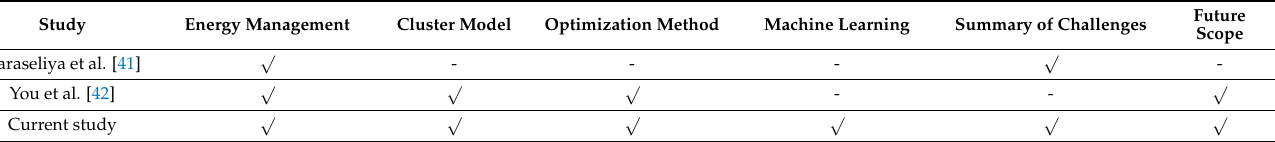
Table 1. Existing method and proposed method